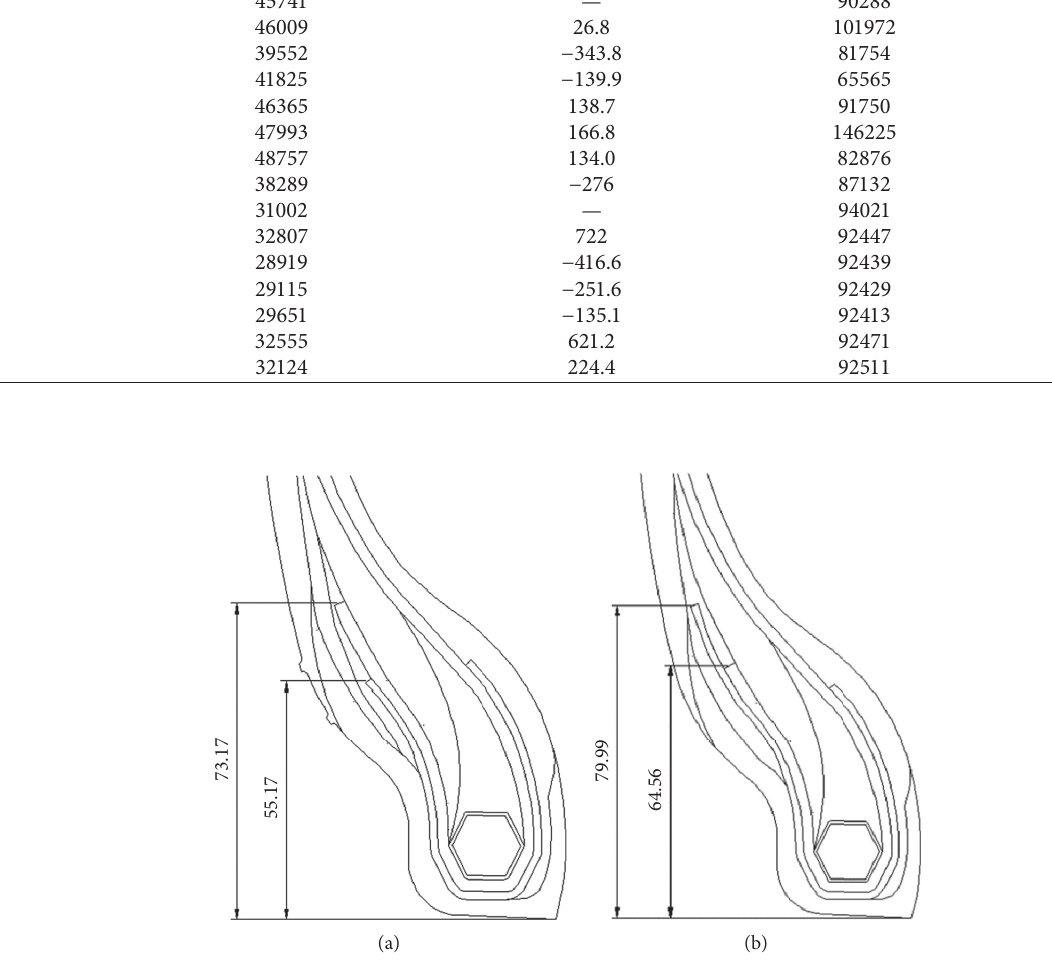
Figure 10: Current design and optimized design of tire material distribution map. (a) Current design. (b) Optimized